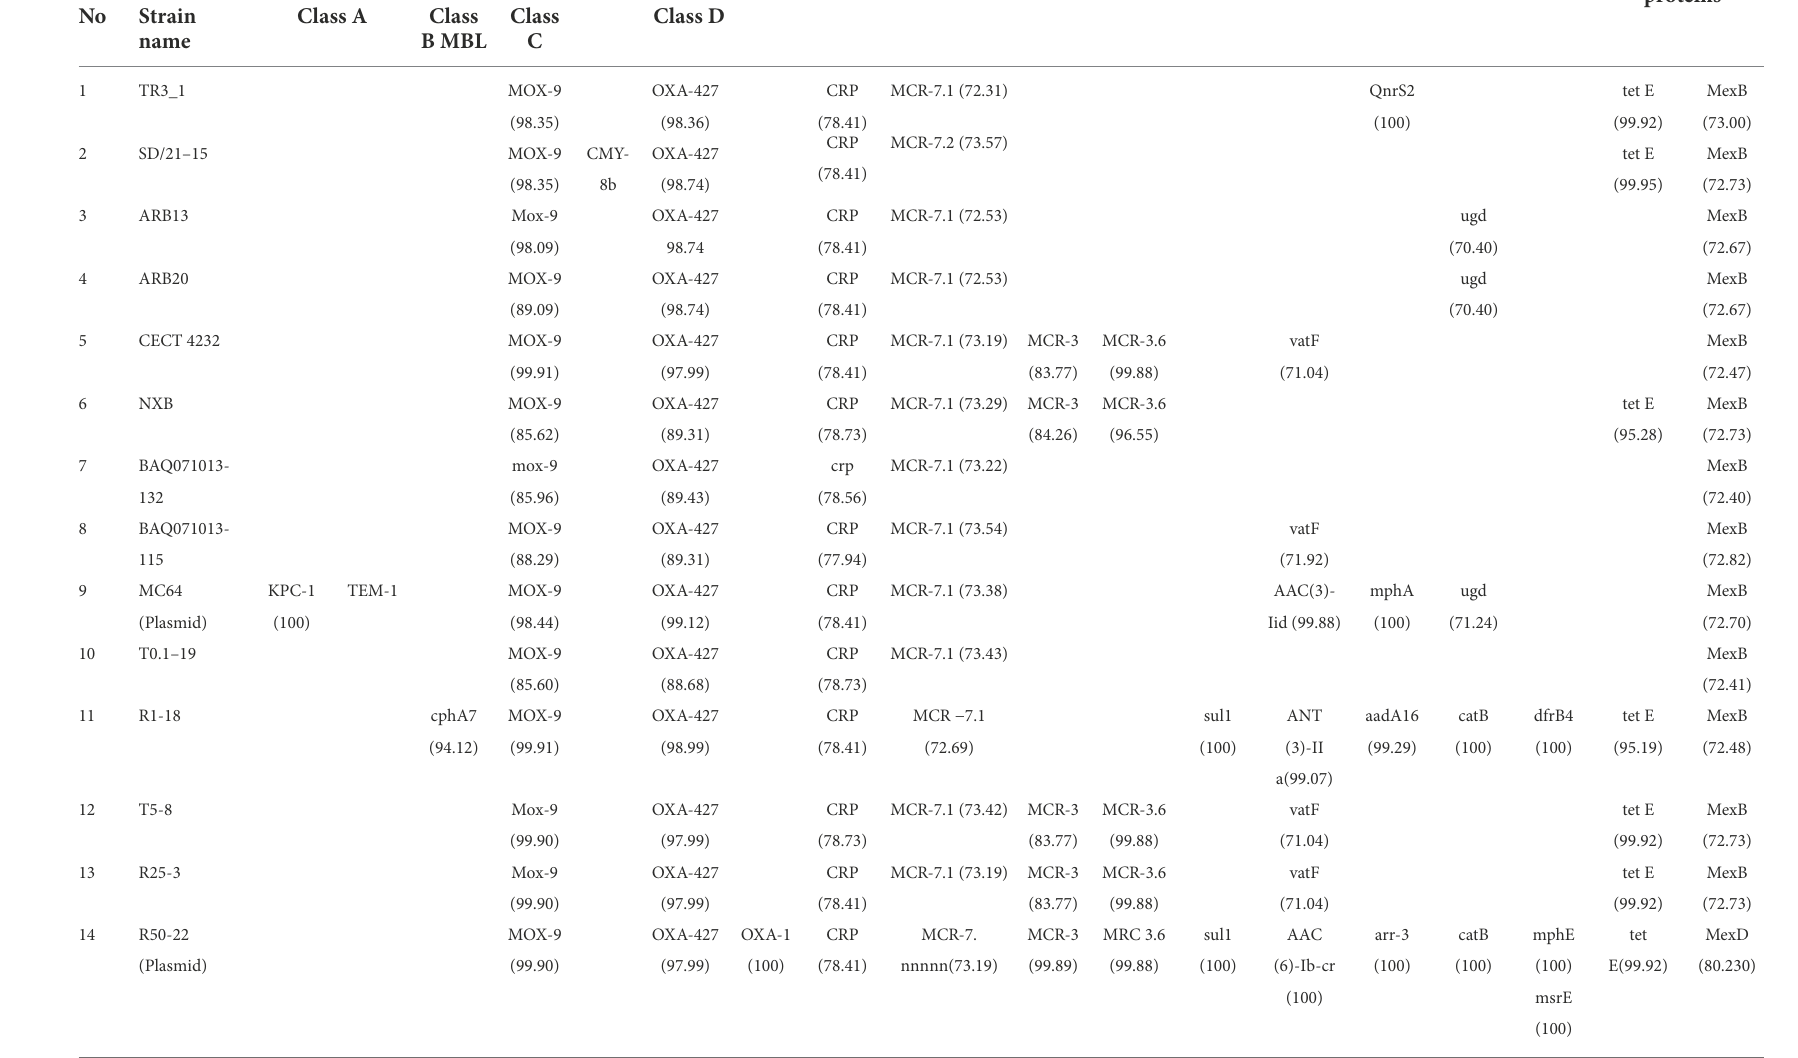
TABLE 4 Antimicrobial resistance and efflux pump proteins detected in the Aeromonas media